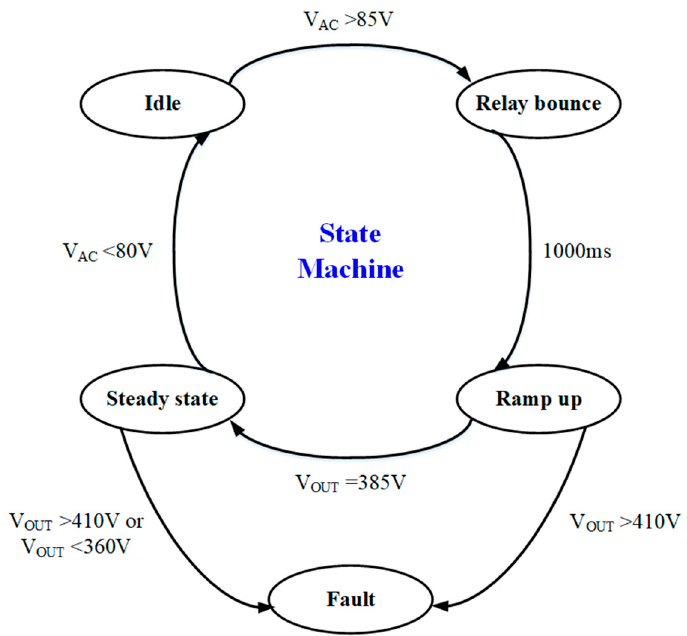
Figure 8. PFC state diagram running in interrupt service routine (ISR).